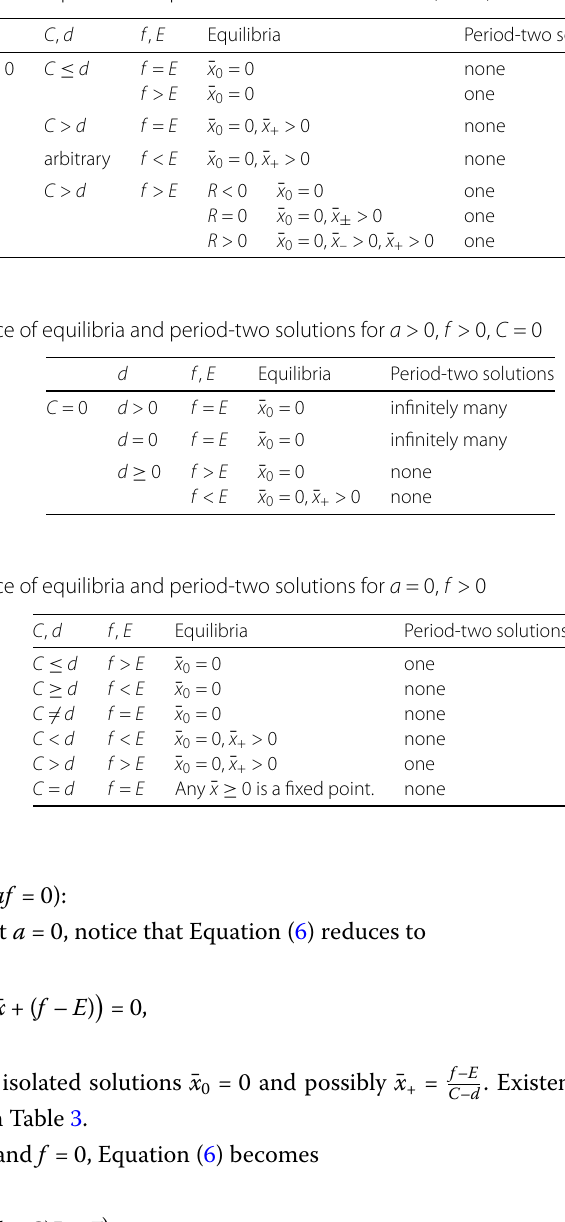
Table 1 Existence of equilibria and period-two solutions for a > 0, f > 0, C > 0